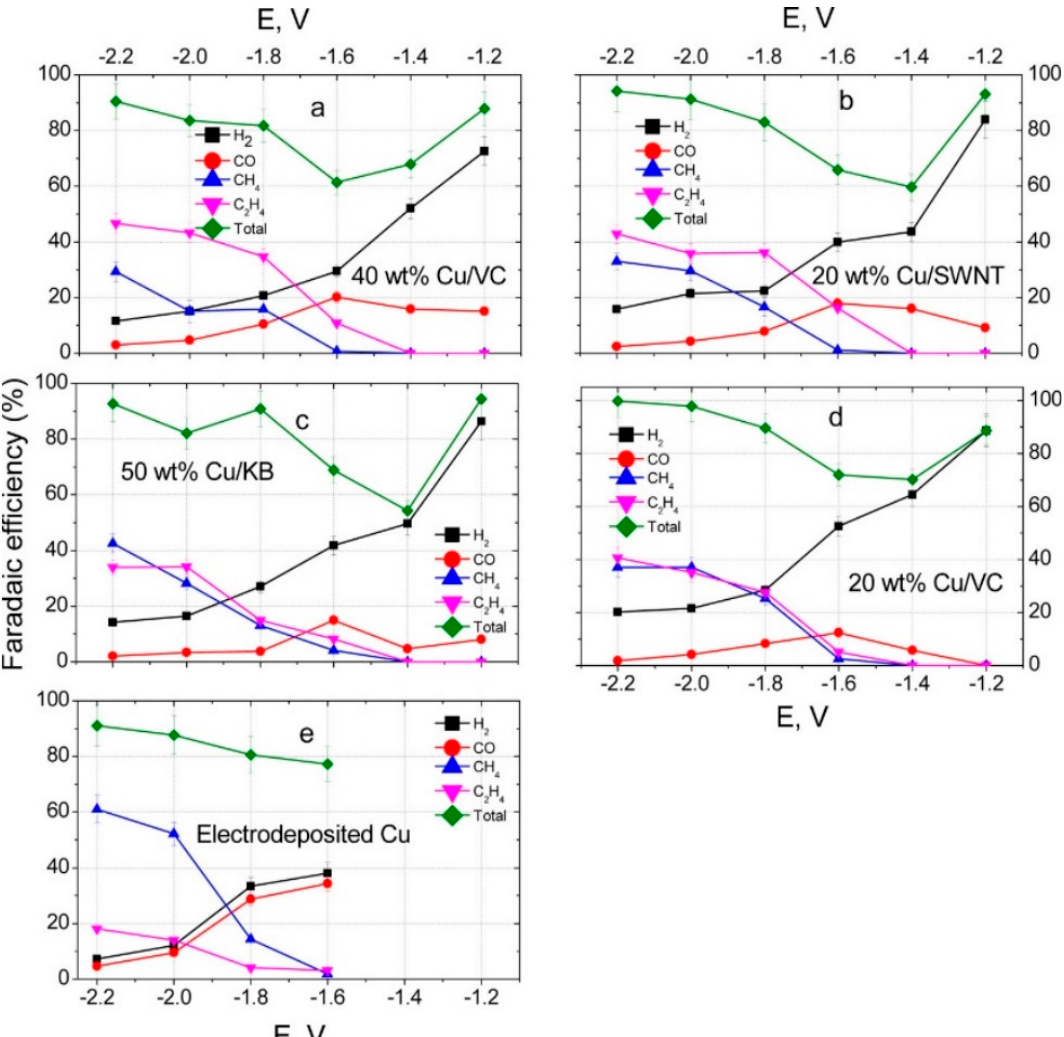
Figure 11. Faradaic efficiencies vs. potential for H 2 (solid black squares), CO (solid red circles), CH 4 (solid blue triangles), and C 2 H 4 (magenta solid upside-down triangles) generation at thin films of ( a ) 40 wt % Cu/VC, ( b ) 20 wt % Cu/SWNT, ( c ) 50 wt % Cu/KB, ( d ) 20 wt % Cu/VC, and ( e ) electrodeposited Cu. Green diamonds: total faradaic efficiencies for H 2 , CO, CH 4 , and C 2 H 4 generation. Reprinted (adapted) with permission from [48]. Copyright 2019, American Chemical Society.